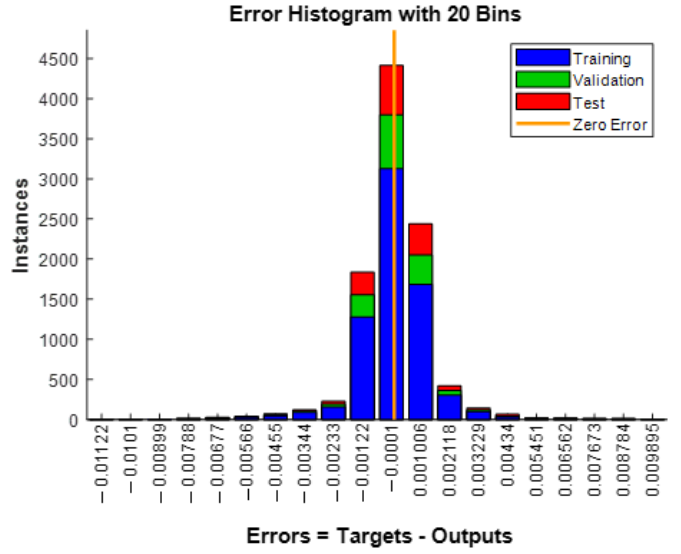
Figure 8. Error histogram with 5 neurons and 100 epochs.